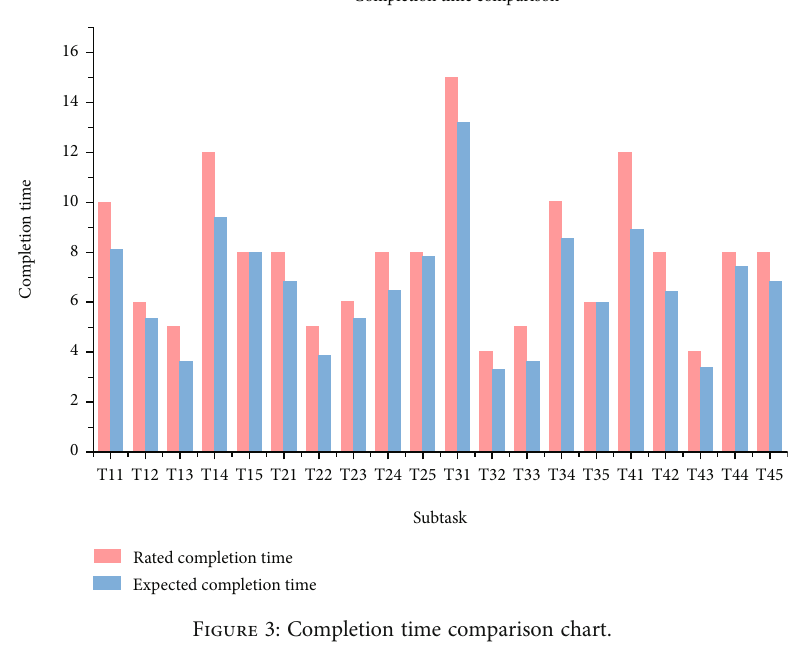
Figure 3: Completion time comparison chart. Table 21: WRR-expected completion time. Task